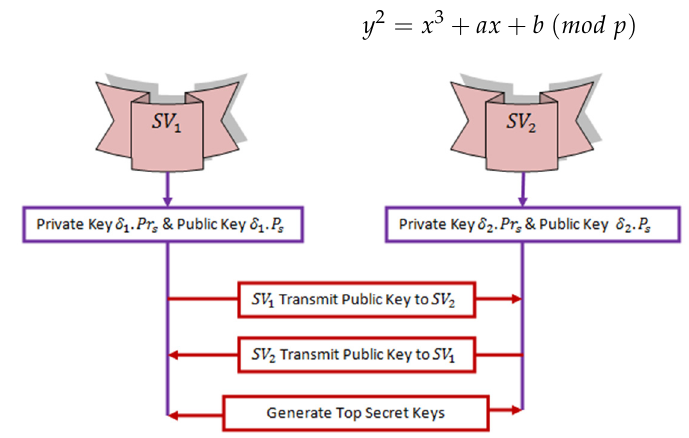
Figure 8. Vehicular Communication with ECC-based Top Secret Key.